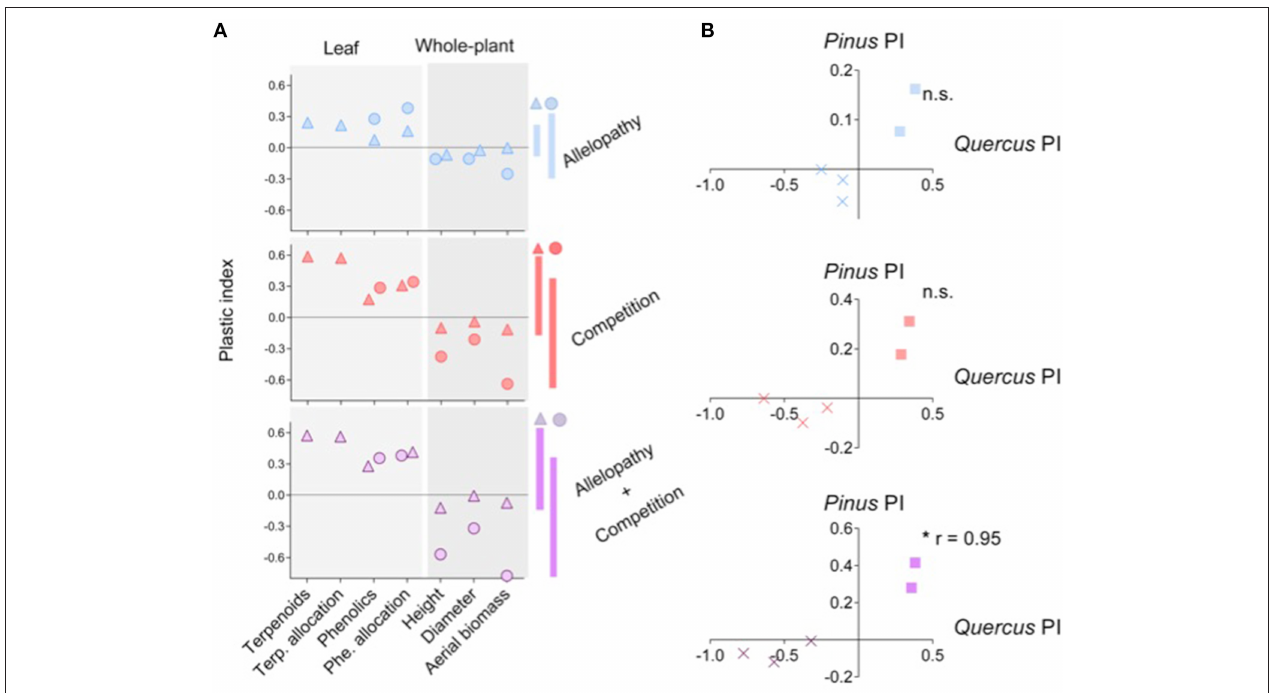
FIGURE 6 | Overall Phenotypic Responses (OPR) of Pinus and Quercus to the three interference treatments. Global representation (A) of plastic index (PI) of 7 selected traits in response to Allelopathy (blue symbols), Competition (red symbols) and Allelopathy + Competition (purple symbols) treatments for Pinus (triangles) and Quercus (circle). Positive or negative value of PI for a trait indicates positive or negative phenotypic response, respectively, for this trait to corresponding interference treatment. Vertical bars indicate the magnitude of the OPR in both species to each interference treatment. Pearson correlation (B) between the OPR (cross for growth traits and square for biochemical traits) of both species to Allelopathy (blue symbols), Competition (red symbols) and Allelopathy + Competition (purple symbols) treatments. Asterisks indicate a significant value at P < 0.05 ( * ).